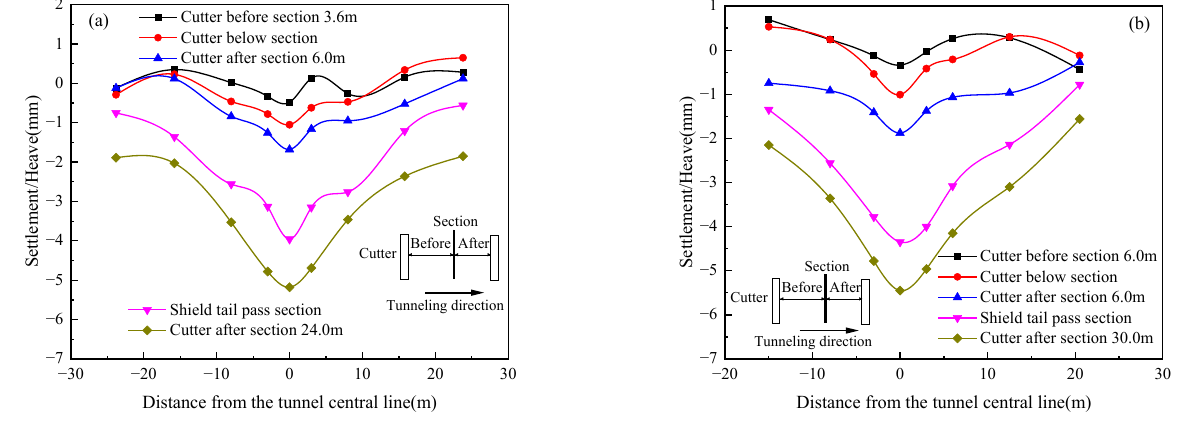
Figure 6. Surface section deformation of the north line: ( a ) SSP-N-350; ( b ) SSP-N-370.